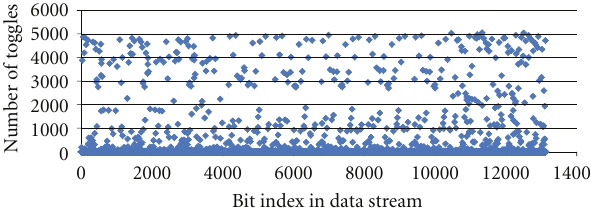
Figure 16: Number of single bit value changes for the di ff erent bit indices over 10,000 measurements on device